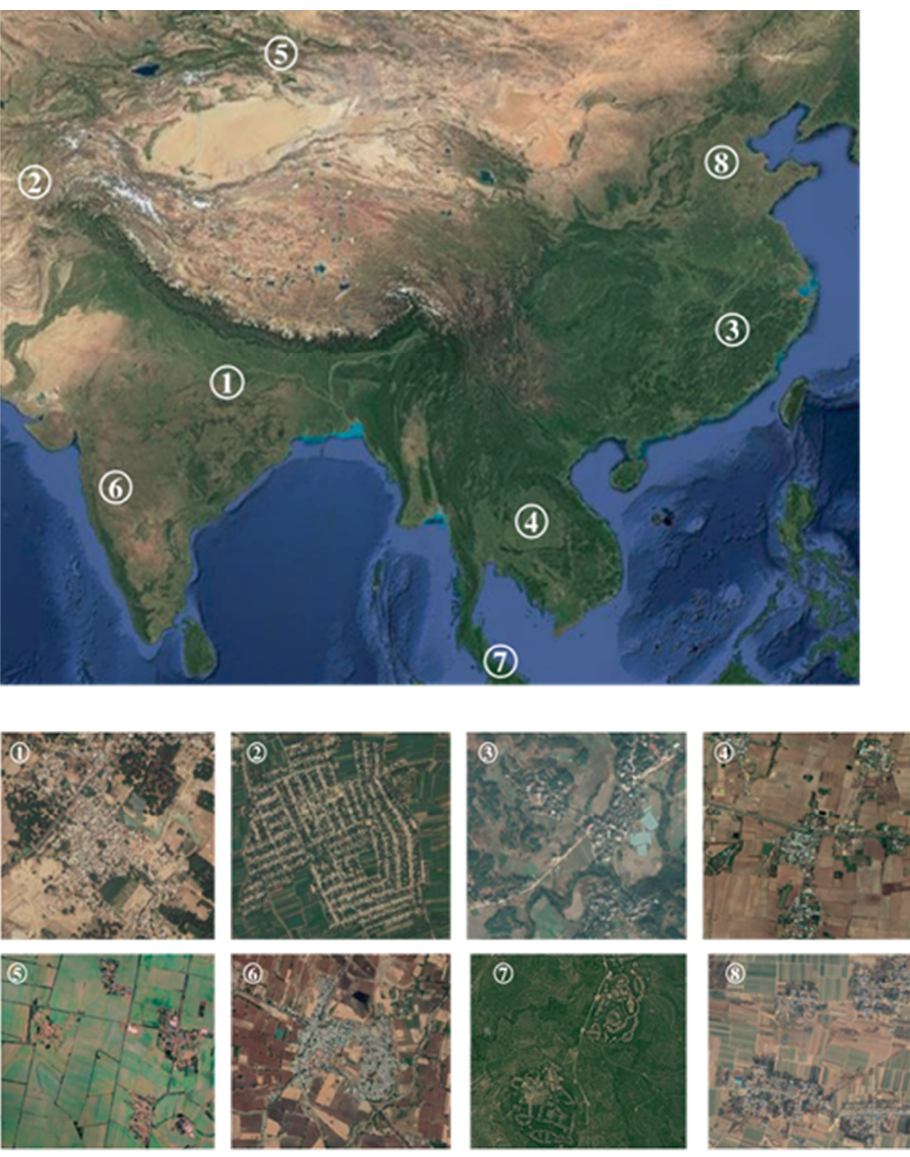
Figure 1. The spatial distribution of selected research regions in this study:(1) Northern India (NI); (2) Central Asia (CA); (3): Southern China (SC); (4), Central Thailand (CT); (5) Northern Xinjiang (NX); (6) Southern India (SI); (7) Northern Malaysia (NM); (8): North China (NC).